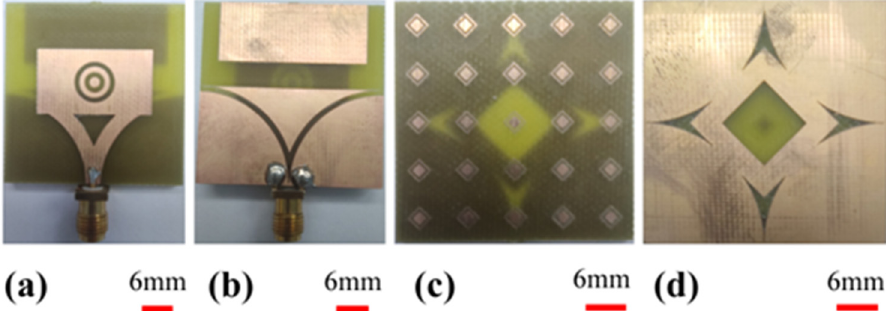
Figure 4. Fabricated prototype: ( a ) microstrip patch antenna front view, ( b ) microstrip patch antenna rear view, ( c ) AMC structure front view, ( d ) AMC structure rear view.